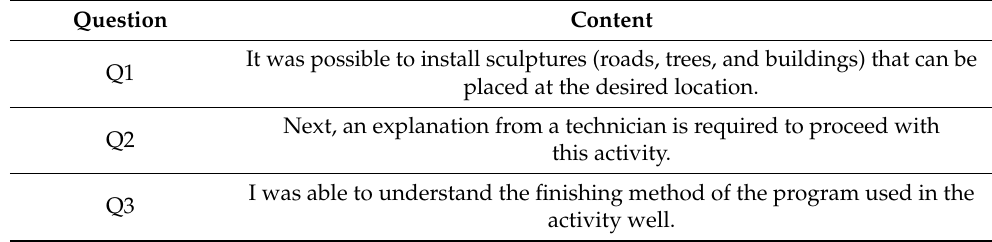
Table 5. Survey contents of personal